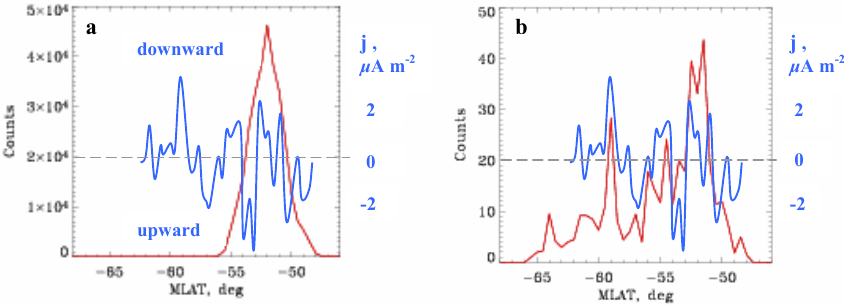
Fig. 4. Latitudinal distribution of the emission detected by the (a) WIC and (b) SI12 cameras (both are shown in red), together with the field- aligned current deduced from the magnetic perturbations measured on board the Demeter (in blue). Upward and downward are represented, respectively, by the negative and positive current density. Both observations are made along the magnetic local sector comprised between 00:02 and 00:22 MLT, which is covered by Demeter when it moves from − 55 ◦ to − 48 ◦ magnetic latitude.